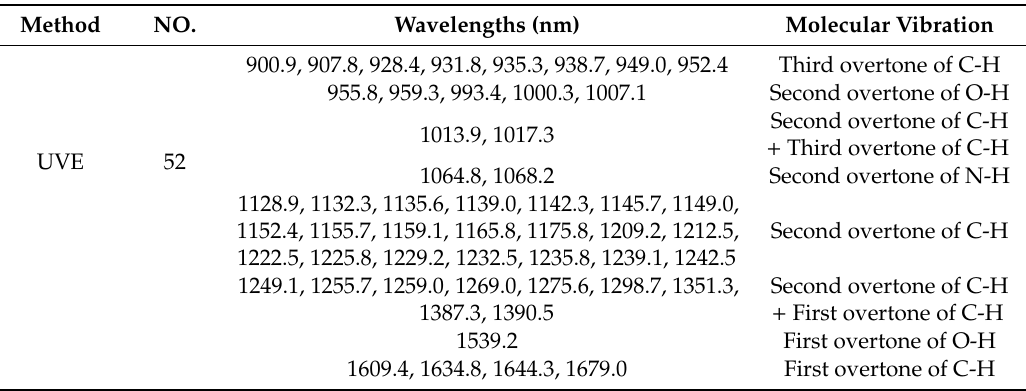
Figure 7. Variable stability analysis based on uninformative variables elimination (UVE). Table 2. The characteristic wavelengths and the corresponding molecular vibration extracted by uninformative variables elimination (UVE).